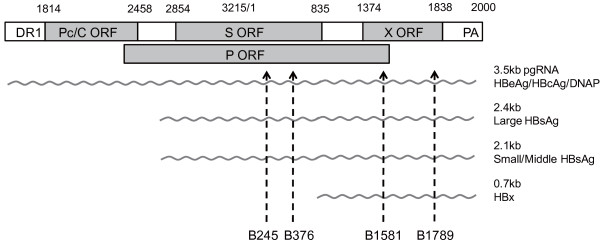
A schematic diagram depicting the locations of siRNA targets in association with viral open reading frames and viral mRNAs within the HBV genome. The circular HBV genome is presented in a linear form. The coding regions for e/core, surface, polymerase, and X proteins are displayed and designated as Pc/C, S, P, and X, respectively. The relative locations of the target sites of B245, B376, B1581 and B1789 are also indicated by arrowheads.